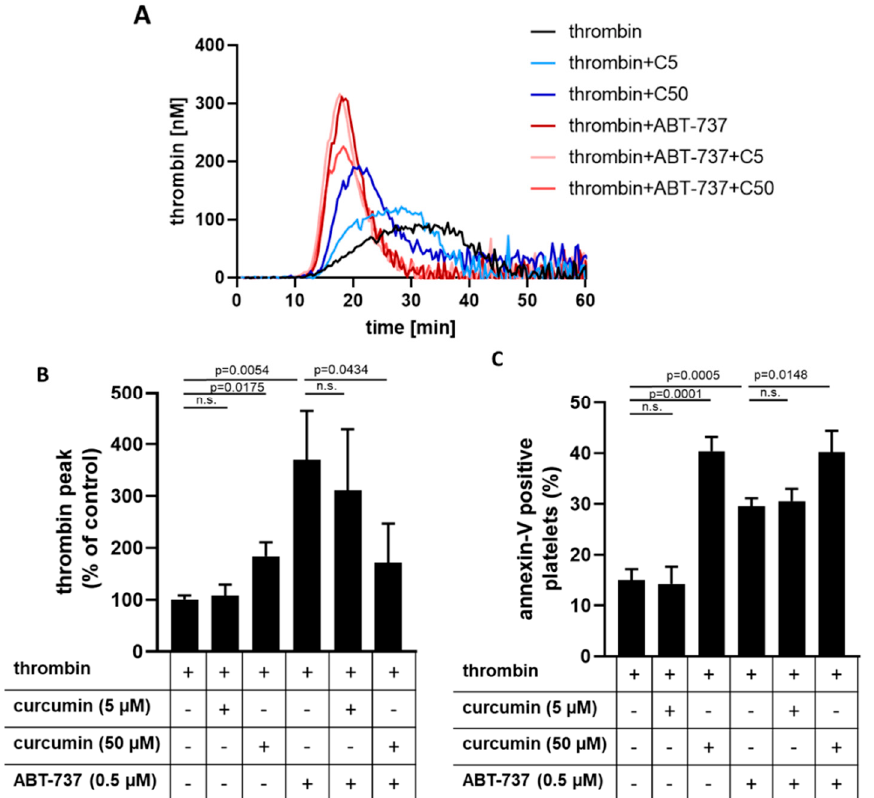
Figure 7. Curcumin at high concentration enhances thrombin-triggered and abolishes ABT-737- mediated thrombin generation on human platelets. Washed platelets (9 × 10 8 cells/mL) were preincubated with curcumin (5 µM/C5, 50 µM/C50) and/or ABT-737 (0.5 µM) for 60 min, adjusted to 1.5 × 10 8 /mL with autologous platelet-free plasma. Platelet-dependent thrombin generation capacity triggered by α -thrombin (0.1 U/mL) was monitored by calibrated automated thrombography. ( A ) Representative thrombogram curves. ( B ) Quantitative thrombin generation data expressed as thrombin peak in % compared to thrombin control. ( C ) Quantitative data of annexin-V-PE binding to washed human platelets in platelet-free plasma induced by 0.1 U/mL α -thrombin in the absence or presence of curcumin and/or ABT-737, expressed as a percentage of annexin-V-PE positive platelets. Data are presented as means ± SD of 3 separate experiments from 3 different donors (One-way ANOVA, Levene’s test p > 0.05 followed by Tukey’s HSD test), n.s. not